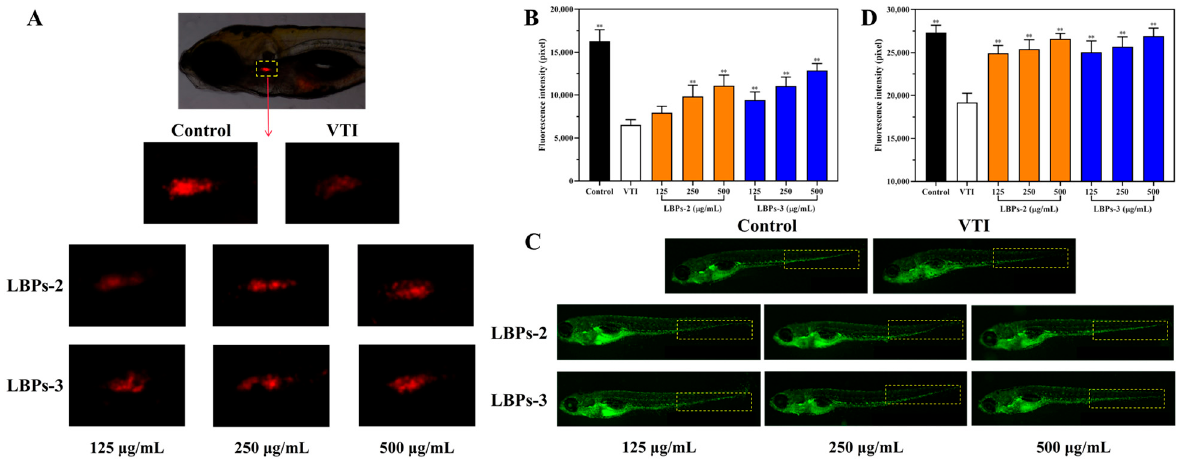
Figure 9. Effect of LBPs-2 and LBPs-3 on T-lymphocytes and macrophages in VTI-treated zebrafish. Fluorescence intensity of T-lymphocytes in zebrafish ( A ), Experimental results of the pro-proliferative effect of LBPs-2 and LBPs-3 on T-lymphocytes ( B ), Fluorescence intensity of macrophages in zebrafish ( C ), Experimental results of the pro-proliferative effect of LBPs-2 and LBPs-3 on T-lymphocytes ( D ). All data are presented as the mean ± SD ( n = 10); * and ** indicate statistically significant differences at p < 0.05 and p < 0.01 compared to the VTI-treated group, respectively.